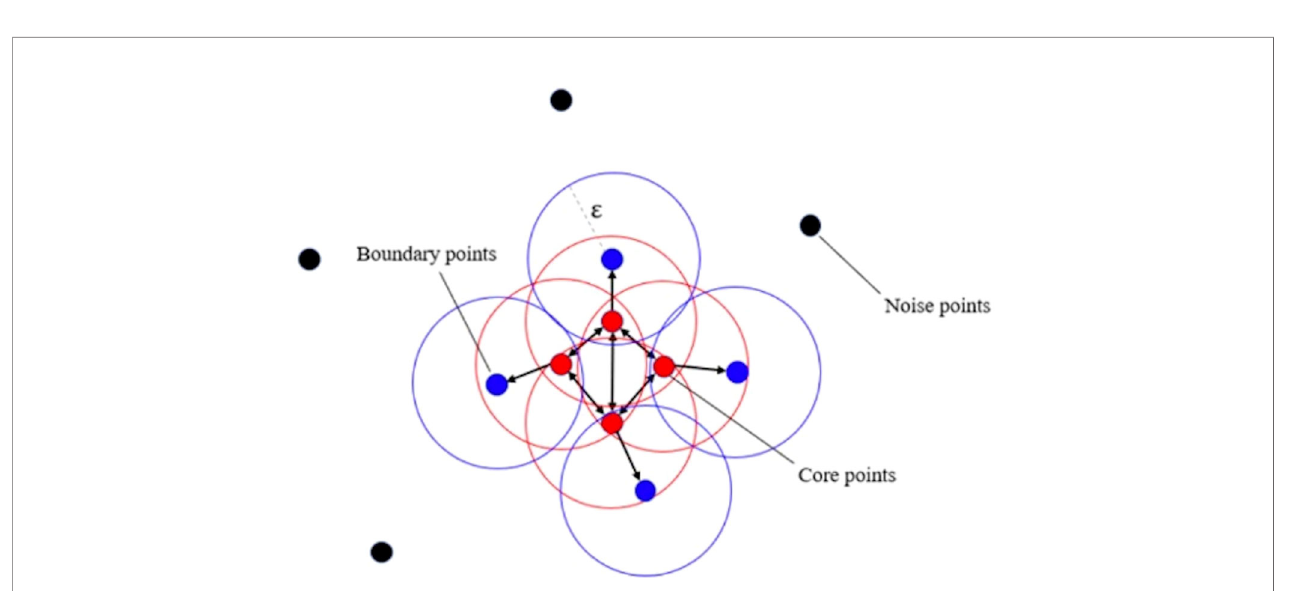
FIGURE 2 | Illustration of density-based spatial clustering of applications with noise